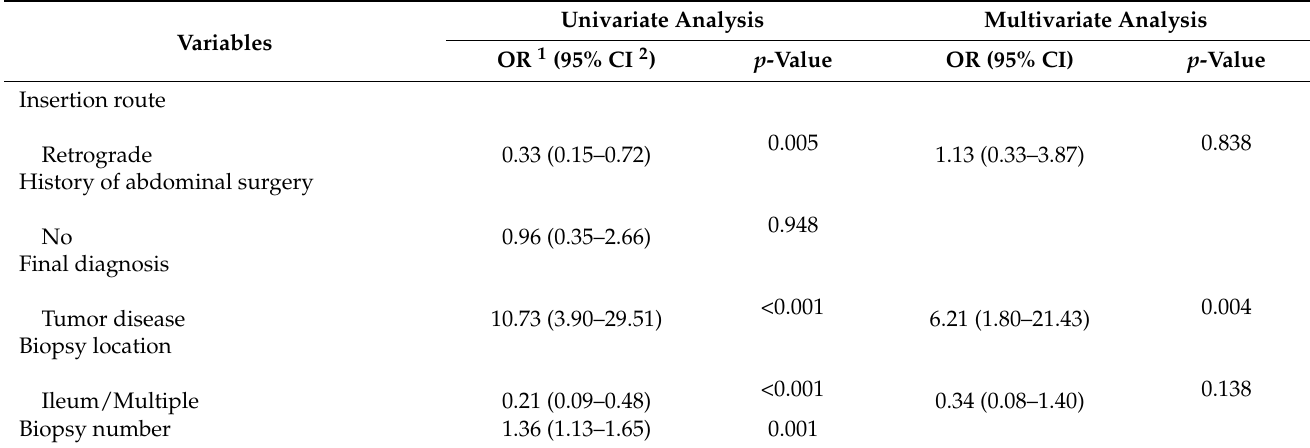
Table 4. Logistic regression analysis of factors for diagnostic yields of enteroscopic